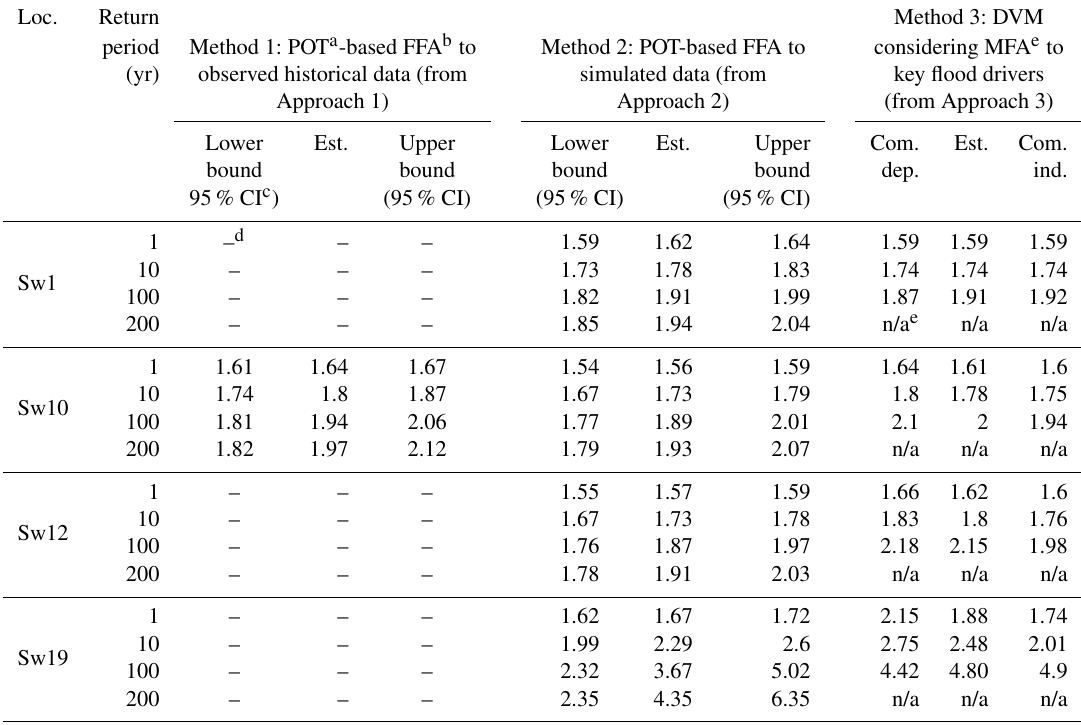
a POT: point over threshold. b FFA: flood frequency analysis. c CI: confidence interval. d “–” indicates no data available. e “NA” indicates not applicable for extrapolation. e MFA: multivariate frequency